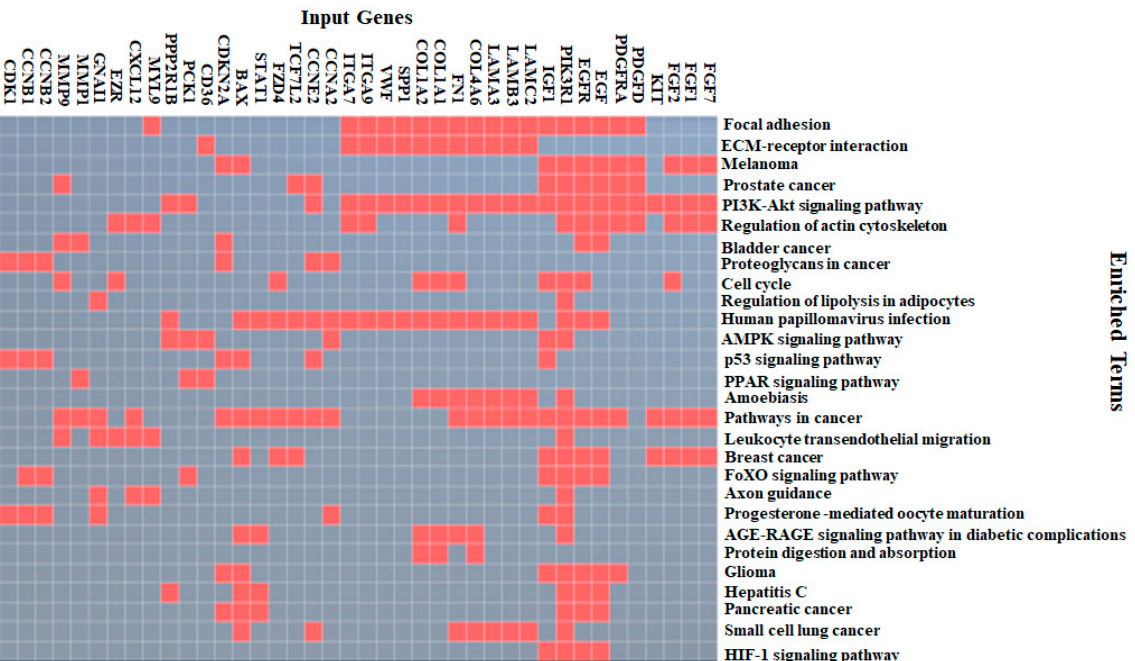
Figure 3. The top 40 genes that were highly enriched in the KEGG